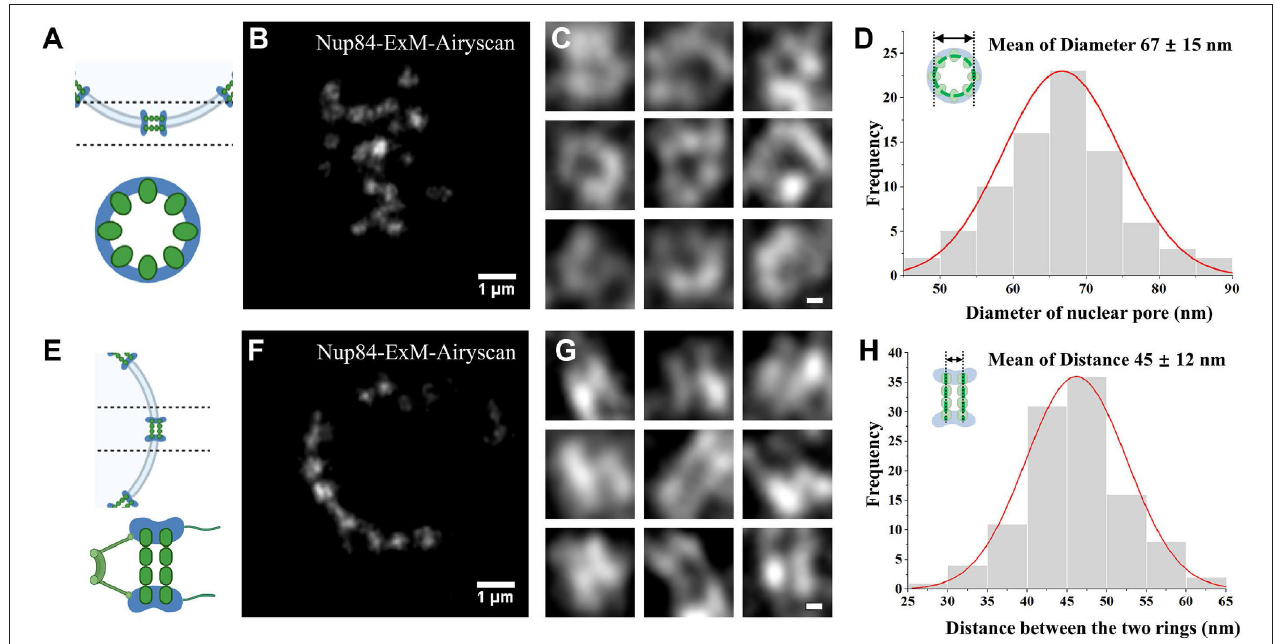
FIGURE 2 | NPC visualized by Airyscan microscopy. (A) Diagram of a radial distribution. (B) Bottom surface imaging of the expansion in Nup84. (C) Images of a radial individual nuclear pore. (D) Diameter histogram of the number of Nup84 molecules. (E) Schematic diagram of the radial view. (F) Post-expanded Nup84 images in the axial view at the equator. (G) Images of single nuclear pore in the axis. (H) Histogram of the separation between rings. Scale bars, 1 µ m (B,F) and 0.1 µ m (C,G) . All bars were physical scales before correction with expansion factor. The expansion factor is 4.0.